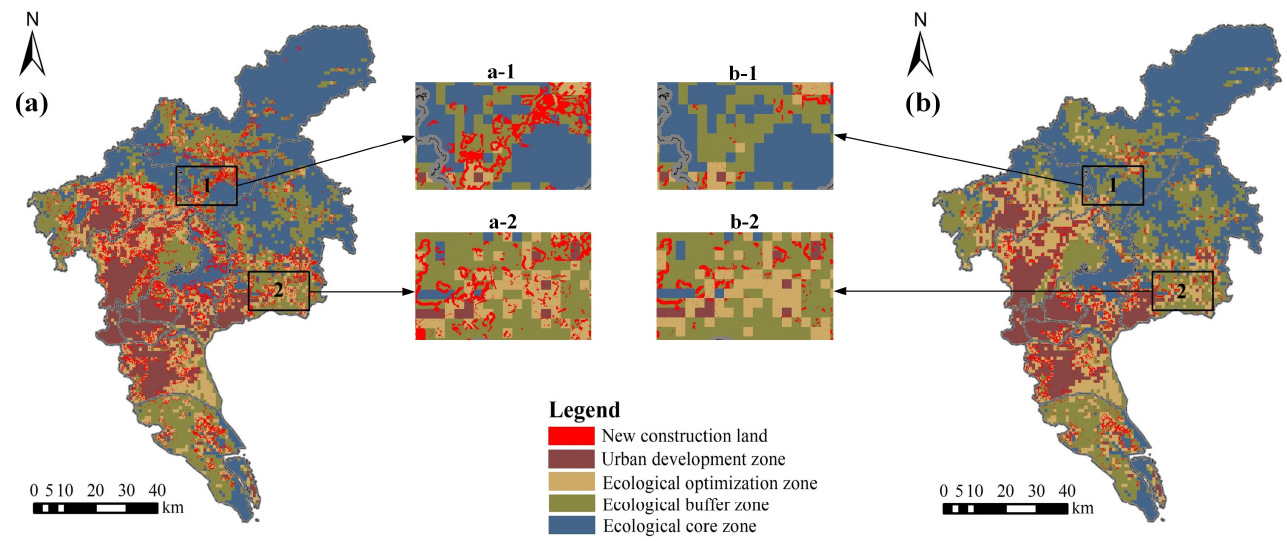
Figure 6. Distribution map of new construction land in different ecological zones: ( a ) ND scenario; ( b ) EP scenario. Table 5. Land use area and proportion in ecological zones.